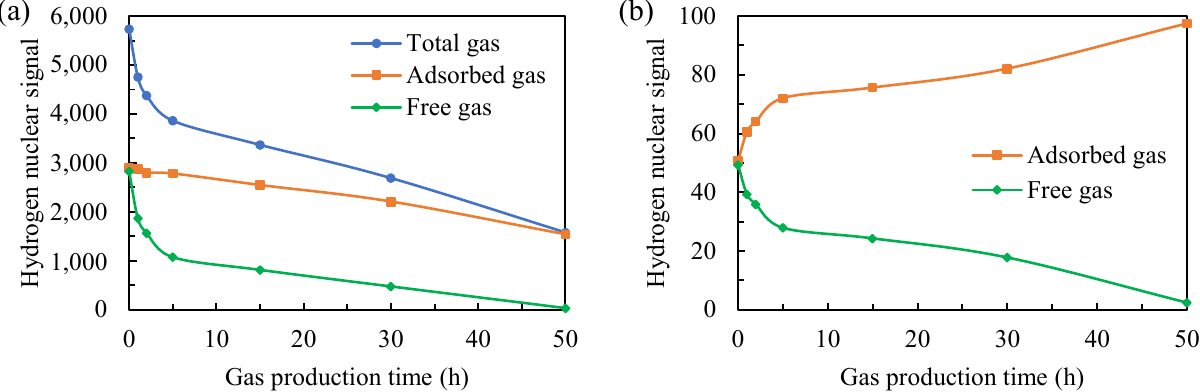
Figure 8. The changing trend of ( a ) NMR signal and ( b ) the ratio of different methane in the process of gas production. The pressure difference inside and outside the pore first drives the free gas in the large pore to produce. With the decrease in the pressure difference, adsorbed gas begins to desorb into the seepage channel and becomes the dominant type of methane produced by gas wells.